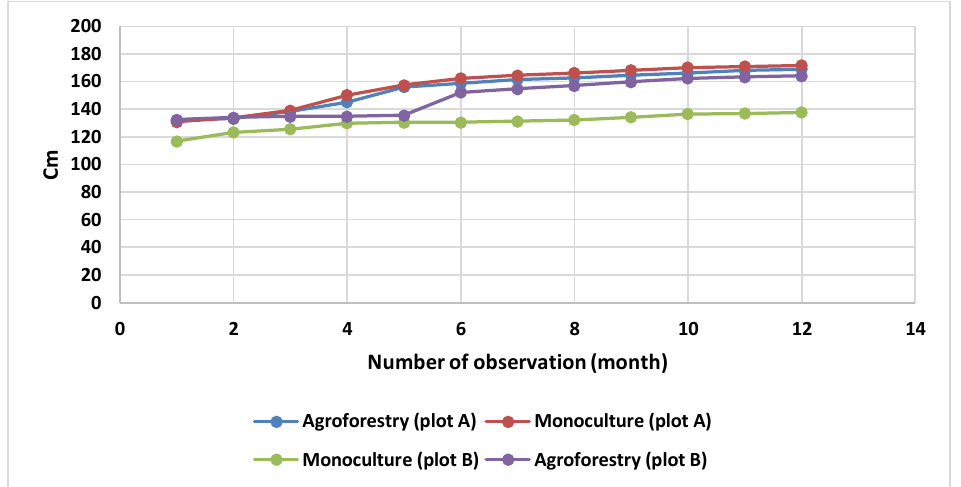
Figure 5. Height growth of nyamplung in monoculture vs. agroforestry plots in Buntoi research site in Central Kalimantan.